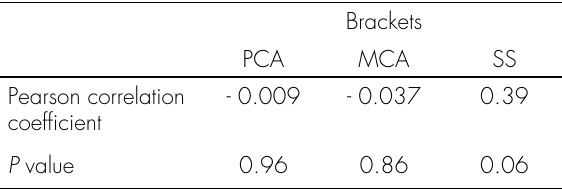
Table IV. Correlation between frictional resistance and average roughness (Sa) parameter of the brackets. (PCA) polycrystalline alumina. (MCA) monocrystalline alumina. (SS) stainless steel.